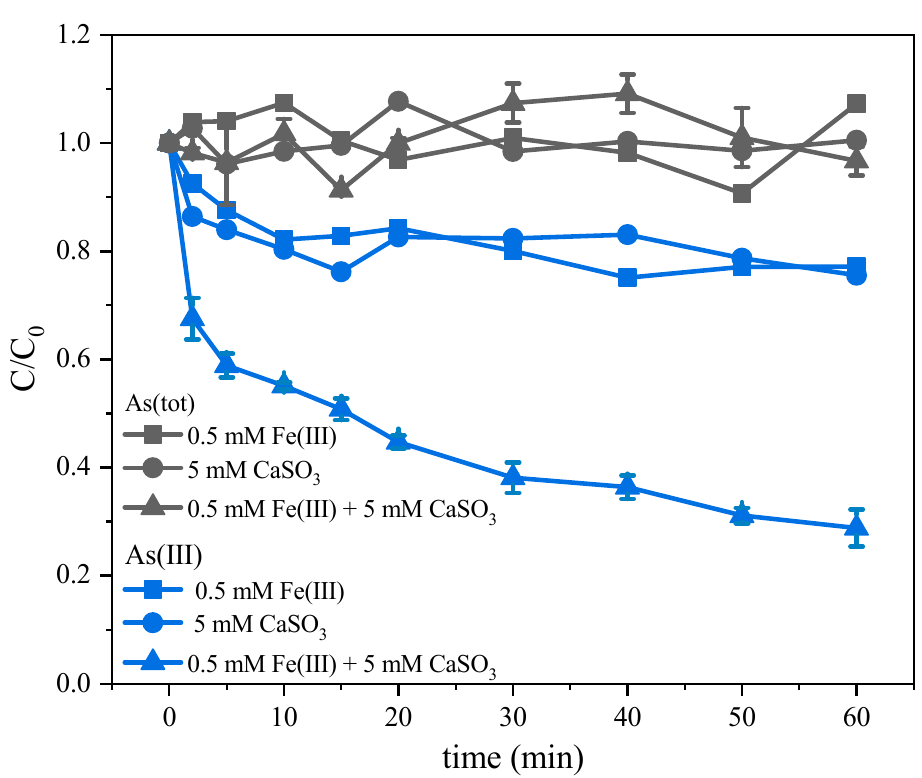
Figure 1. Concentration changes of As(III) and As(tot) in the control experiments of Fe(III)-CaSO 3 system. Initial conditions: [Fe(III)] = 0.5 mM, [CaSO 3 ] = 5 mM, [As(III)] = 5 µ M, pH 6.0, air bubbling at 0.5 L min − 1 .